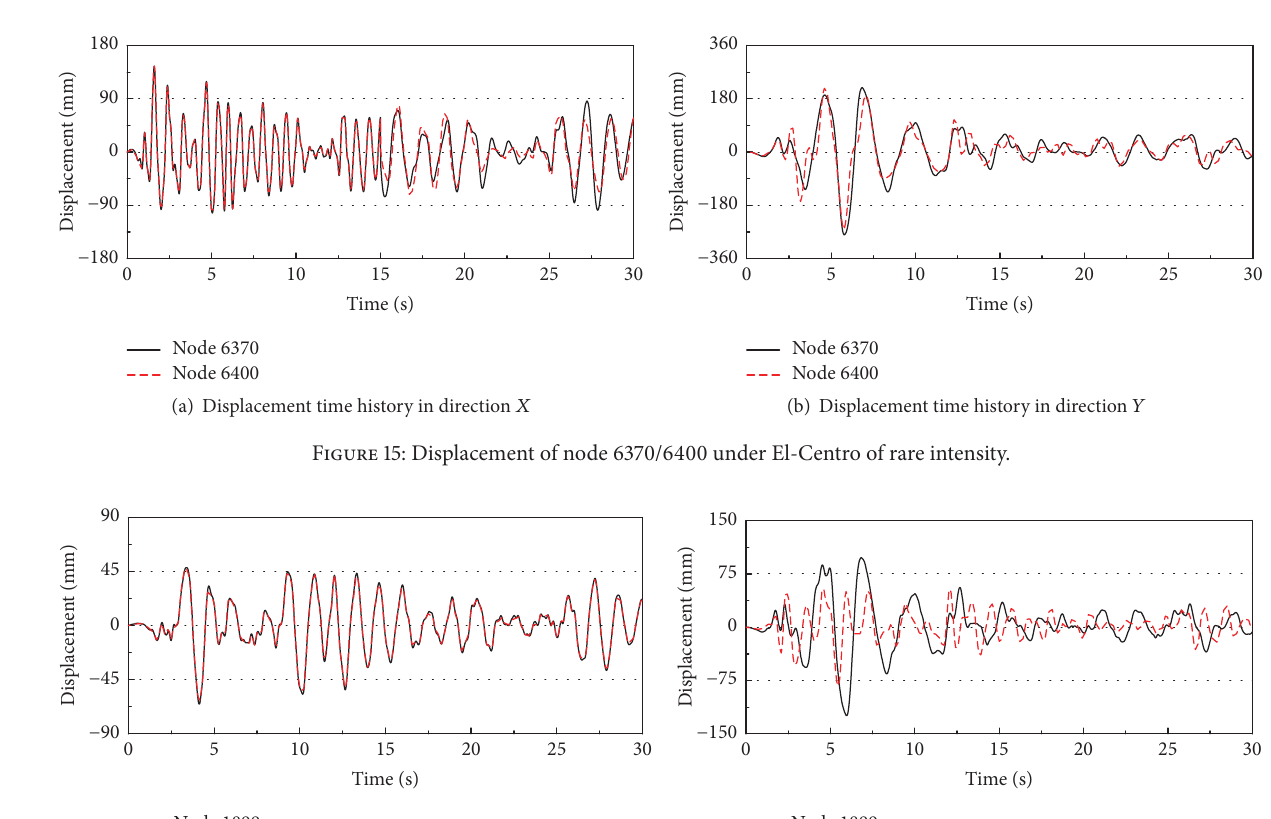
Figure 14: Displacement of node 6228 under Pasadena of rare intensity.